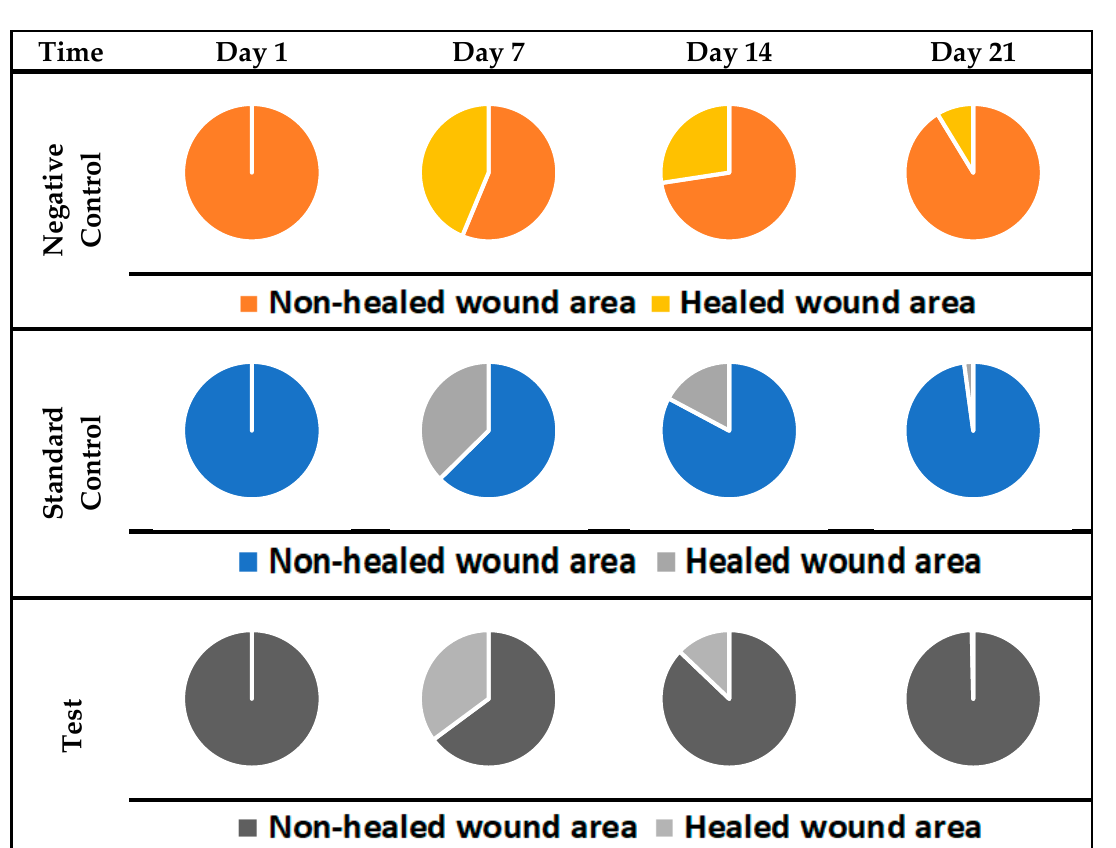
Figure 8. Wound sizes (mm)—fractions of wounds healed by different treatments at days 1, 7, 14 and 21 ( n = 4 * p < 0.05).